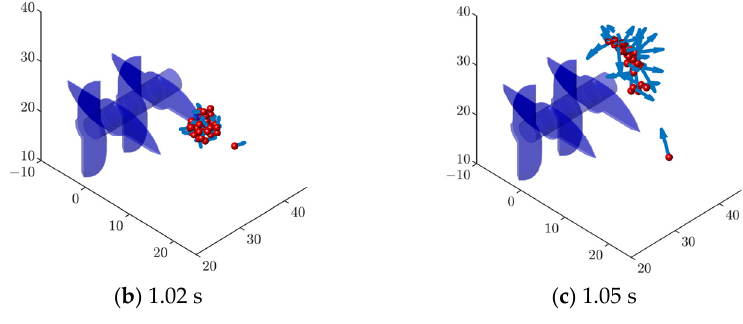
Figure 6. Shear breaking by the chopper.